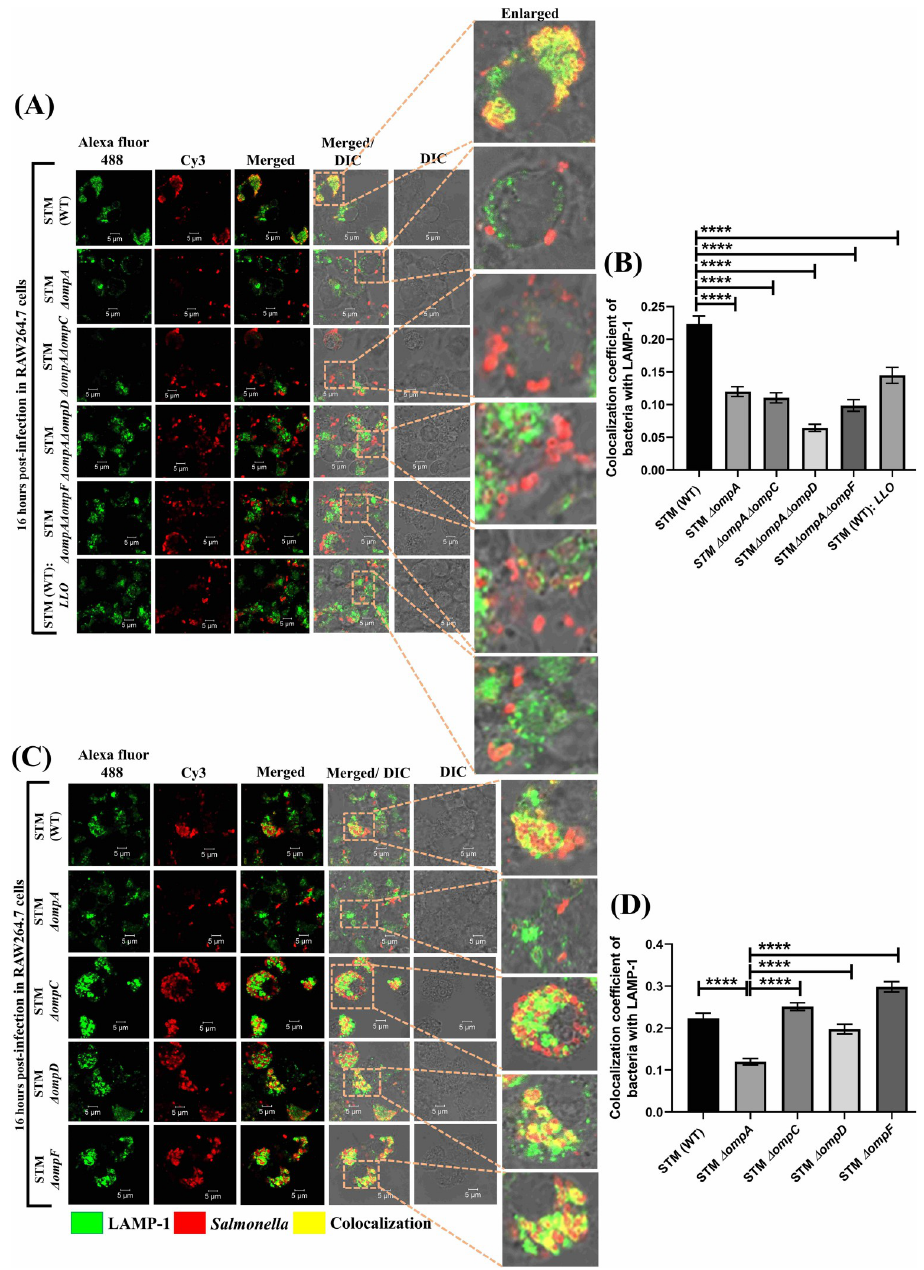
Fig 6. OmpC, OmpD, and OmpF deficiency in Salmonella doesn’t hamper the stability of SCV. (A) Representative image of LAMP-1 recruitment on STM (WT), Δ ompA , Δ ompA Δ ompC , Δ ompA Δ ompD , Δ ompA Δ ompF , & WT: LLO (MOI = 20) in RAW264.7 cells. (B) The colocalization coefficient of bacteria with LAMP-1 was represented as a vertical bar graph (n � 50, N = 2). Scale bar = 5 μ m. (C) RAW264.7 cells were infected with STM (WT), Δ ompA , Δ ompC , Δ ompD , and Δ ompF (MOI 20) to visualize the intracellular niche of the bacteria. (D) Quantifying the colocalization coefficient of bacteria with LAMP-1 (n � 60, N = 2). Scale bar = 5 μ m. Data are represented as mean ± SEM. (P) ���� < 0.0001, (One-way ANOVA) .